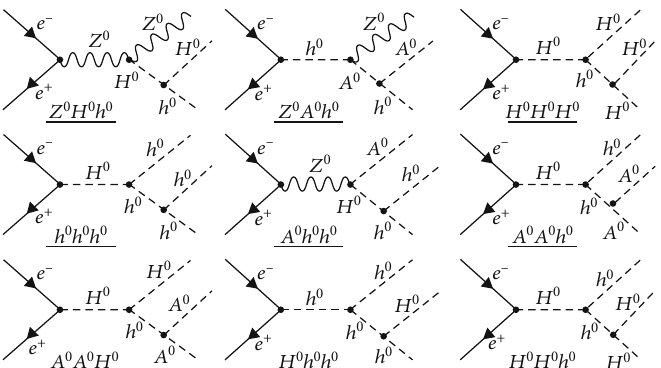
Figure 1: The Feynman diagram of various processes in 2HDM. Their amplitude shows that their cross-section is less than 10 − 11 pb, so their self coupling can be neglected.